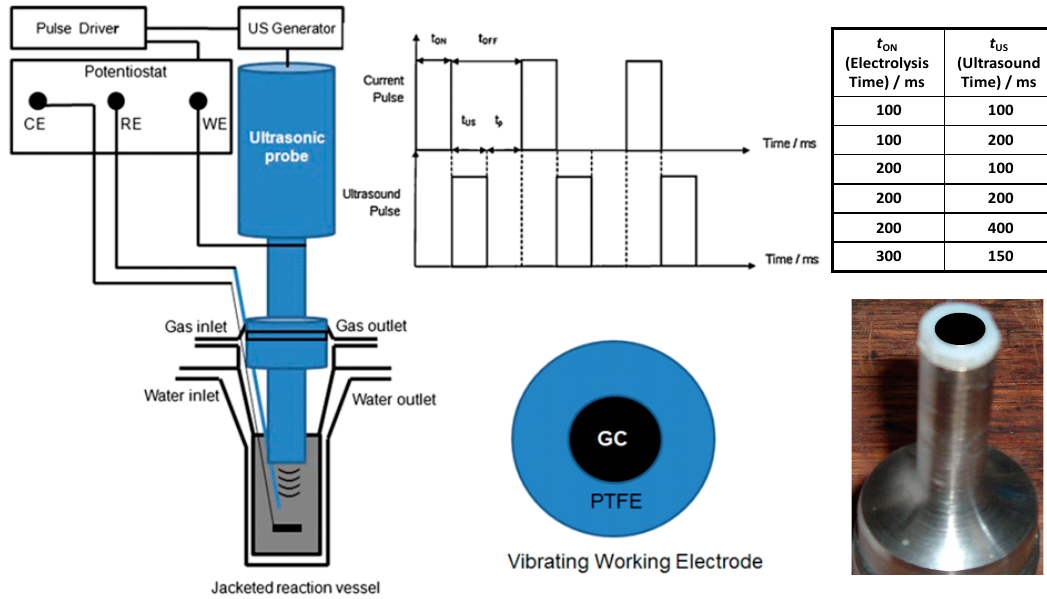
Figure 9. Sonoelectrochemical setup for the production of PEMFC and PEMWE catalysts [17,21,22]. GC: Glassy carbon. PTFE: Polytetrafluoroethylene